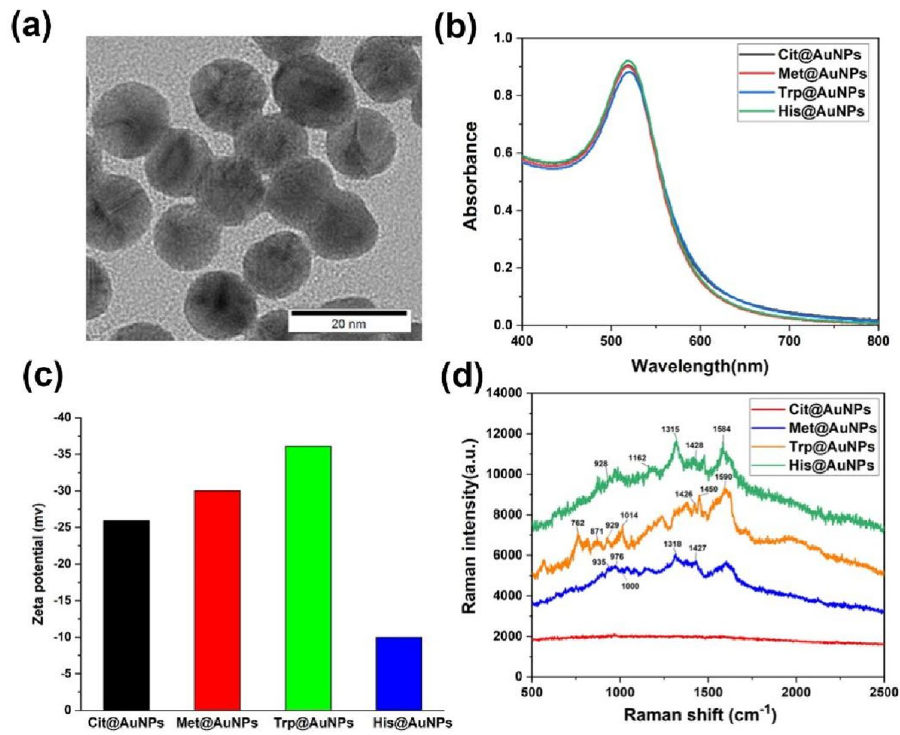
Figure 2. ( a ) TEM image of as-prepared Cit@AuNPs, ( b ) UV–Vis spectrum, ( c ) Zeta potentials, and ( d ) Raman spectra of